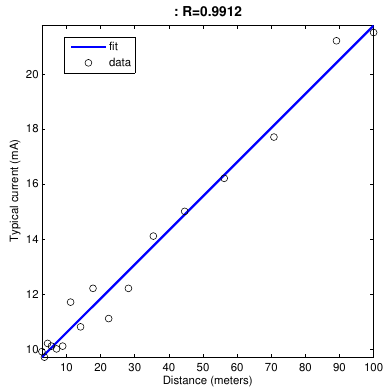
Figure 6. Power consumption vs. distance for CC2500 per packed